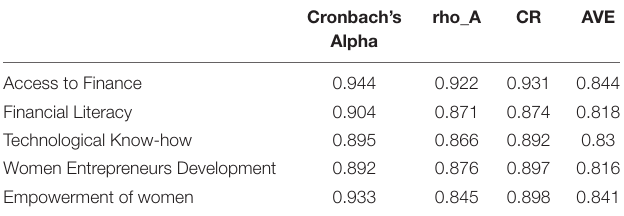
TABLE 6 | Reliability of constructs.